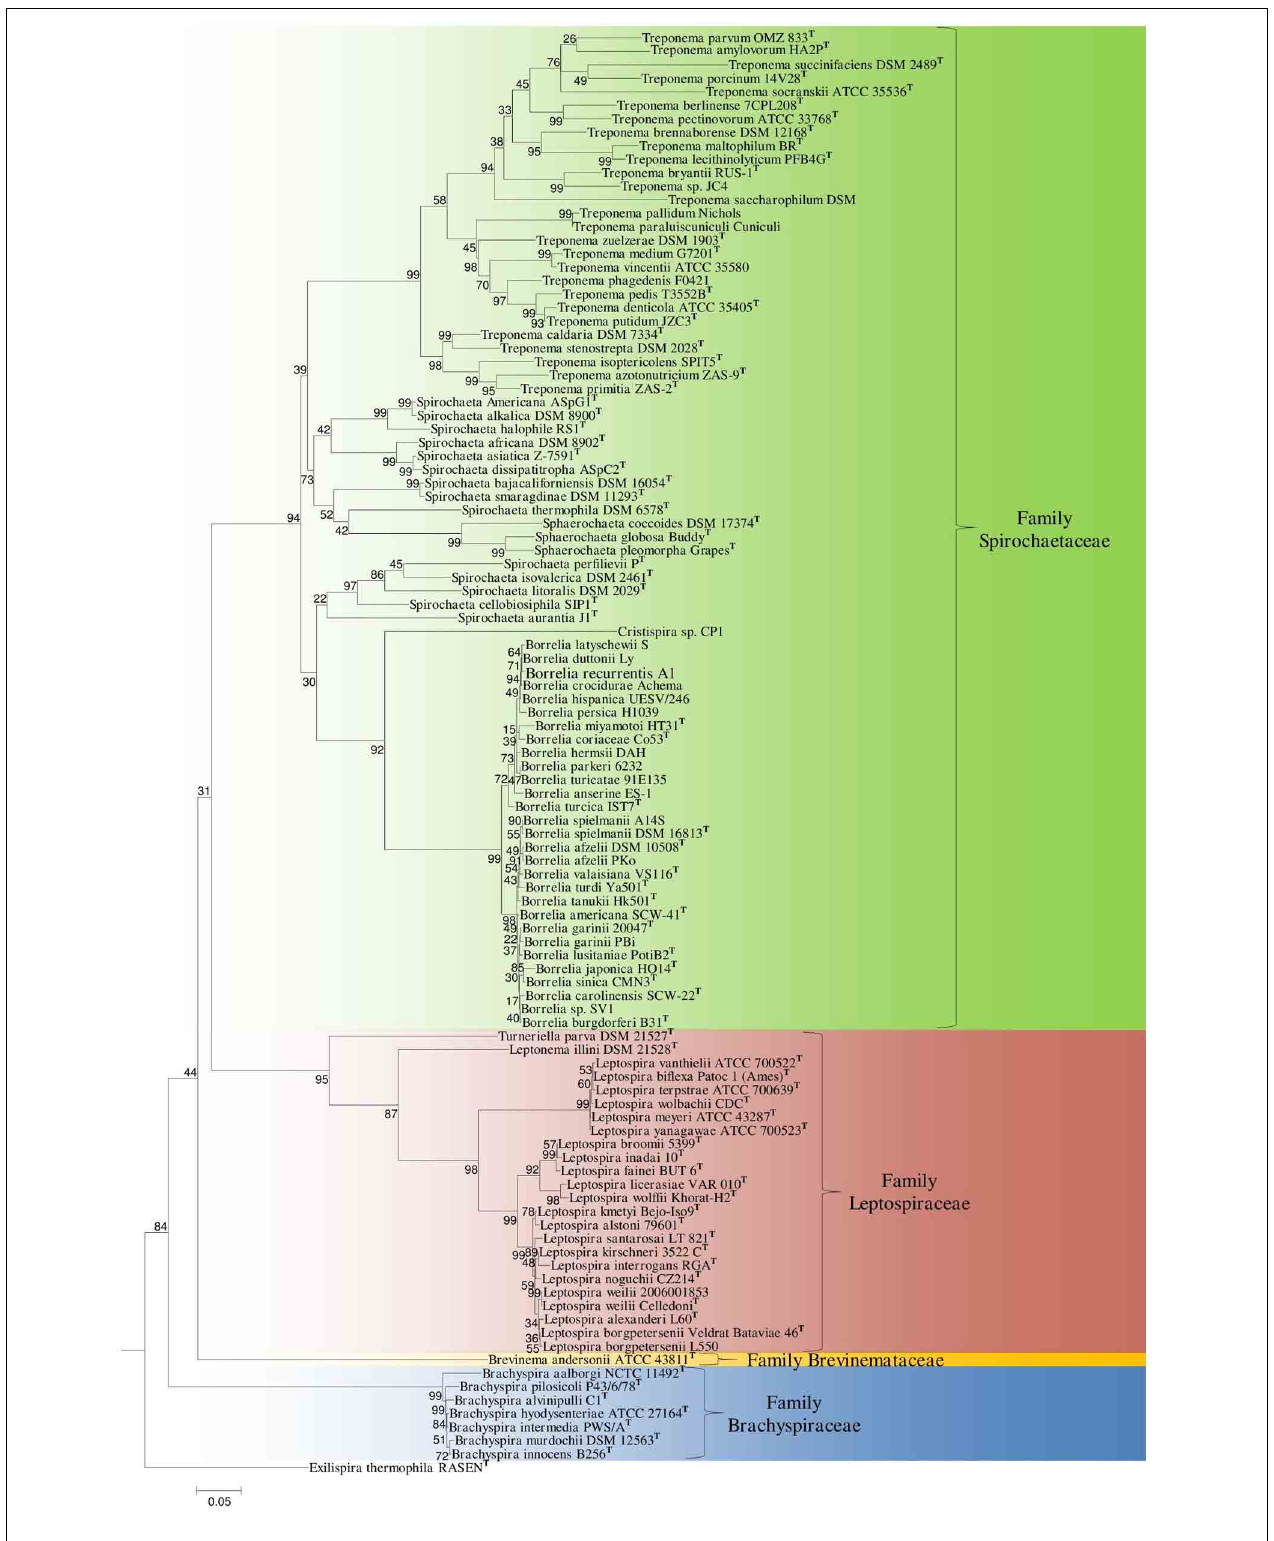
FIGURE 2 | A ML tree based on the 16S rRNA gene sequences of representative species from cultured genera within the phylum Spirochaetes. Bootstrap values are shown at branch nodes. The different